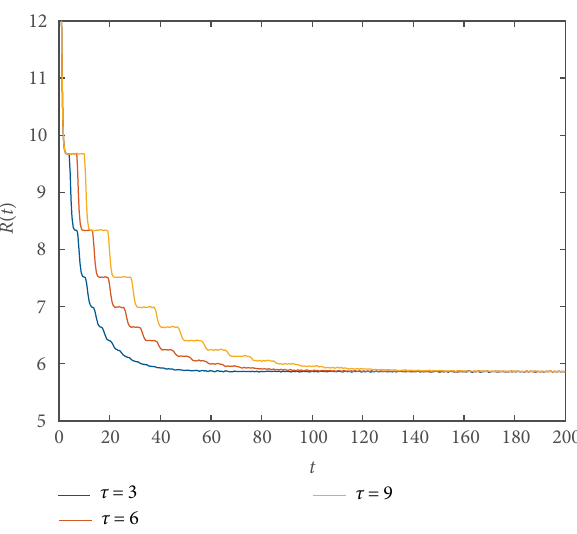
Figure 4: Asymptotic behavior of ̃휎 = 3, 훽 = 2,푅 0 = 12